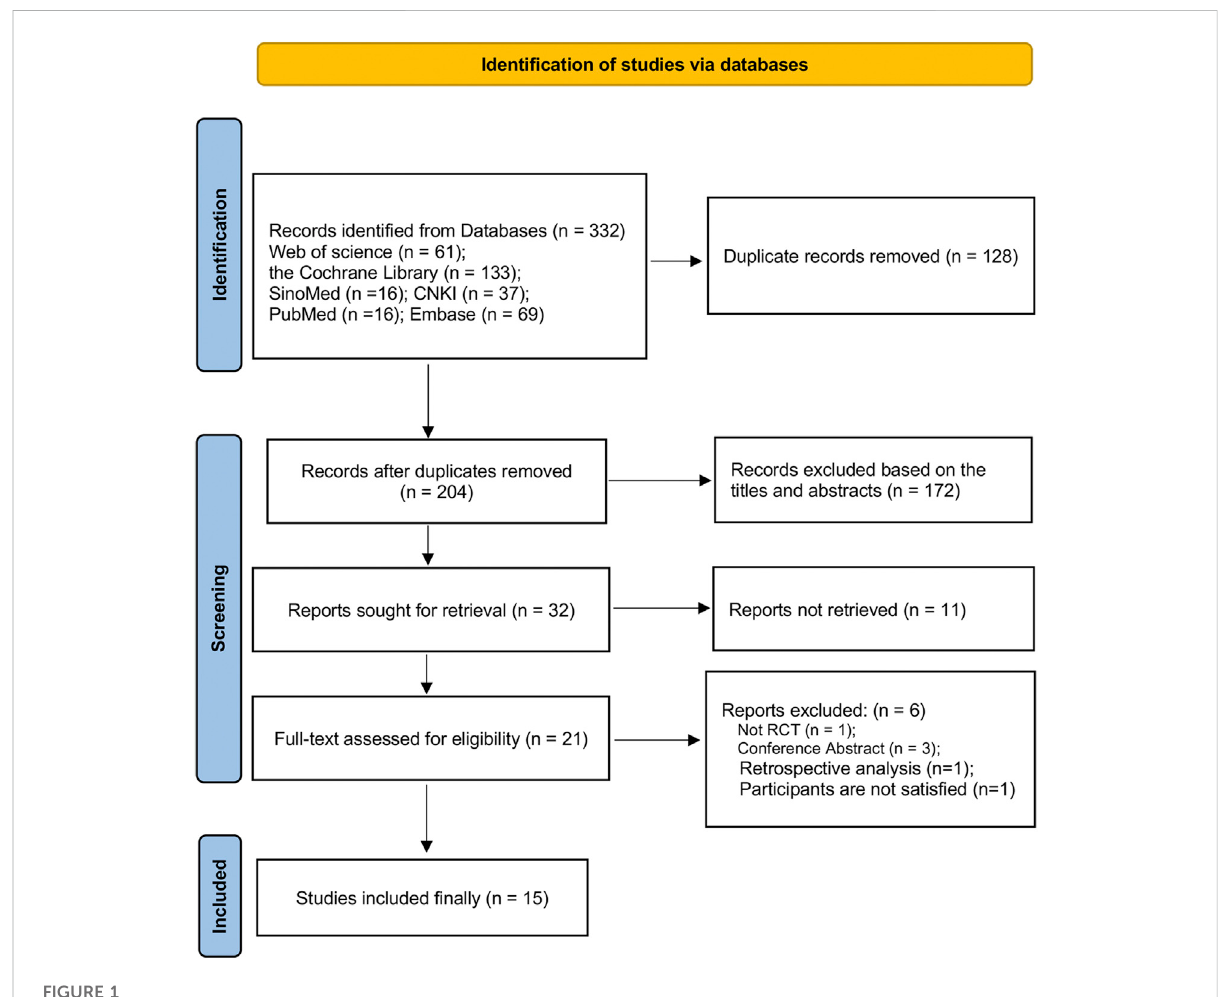
FIGURE 1 The screening fl